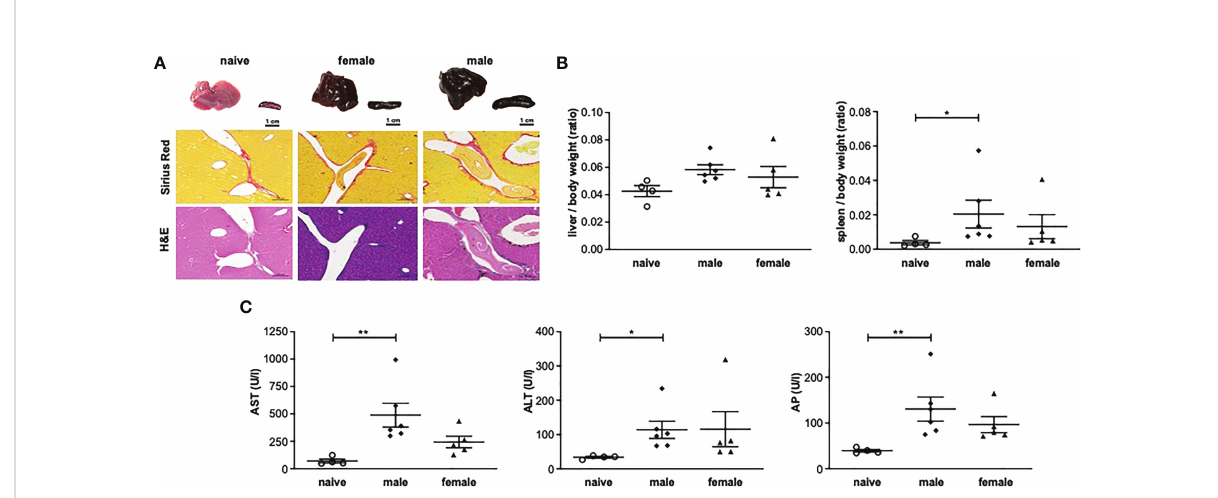
FIGURE 1 One-year unisexual infection with male or female schistosomes leads to persistent organ alterations and hepatic in fl ammation. (A) Representative images of livers and spleens and of liver sections stained with Sirius red (SR) and hematoxylin/eosin (H&E) (magni fi cation 200- fold). (B) Relative organ size of livers and spleens expressed as a ratio to body weight. (C) Serum levels of aspartate aminotransferase (AST), alanine aminotransferase (ALT) and alkaline phosphatase (AP) in male-infected, female-infected and uninfected (naive) control group mice (52